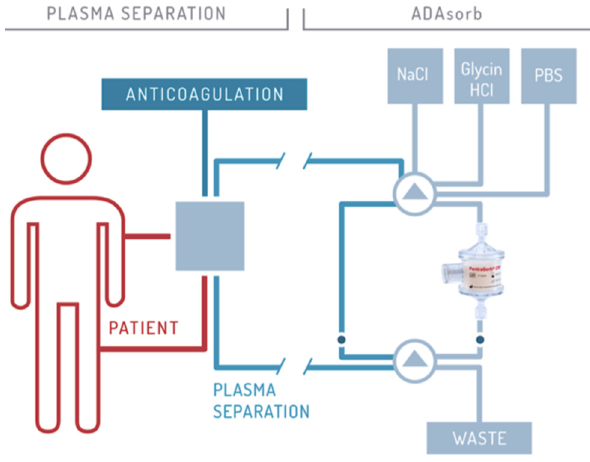
Figure 2. Schematic illustration of CRP apheresis. The procedure is described in detail by Ries et al. 2019 [45]